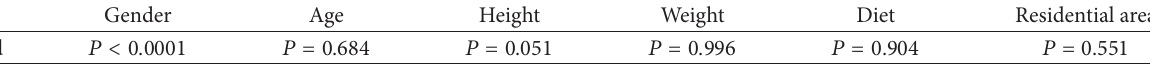
Table 7: Results of Chi-square test between uric acid and other parameters.